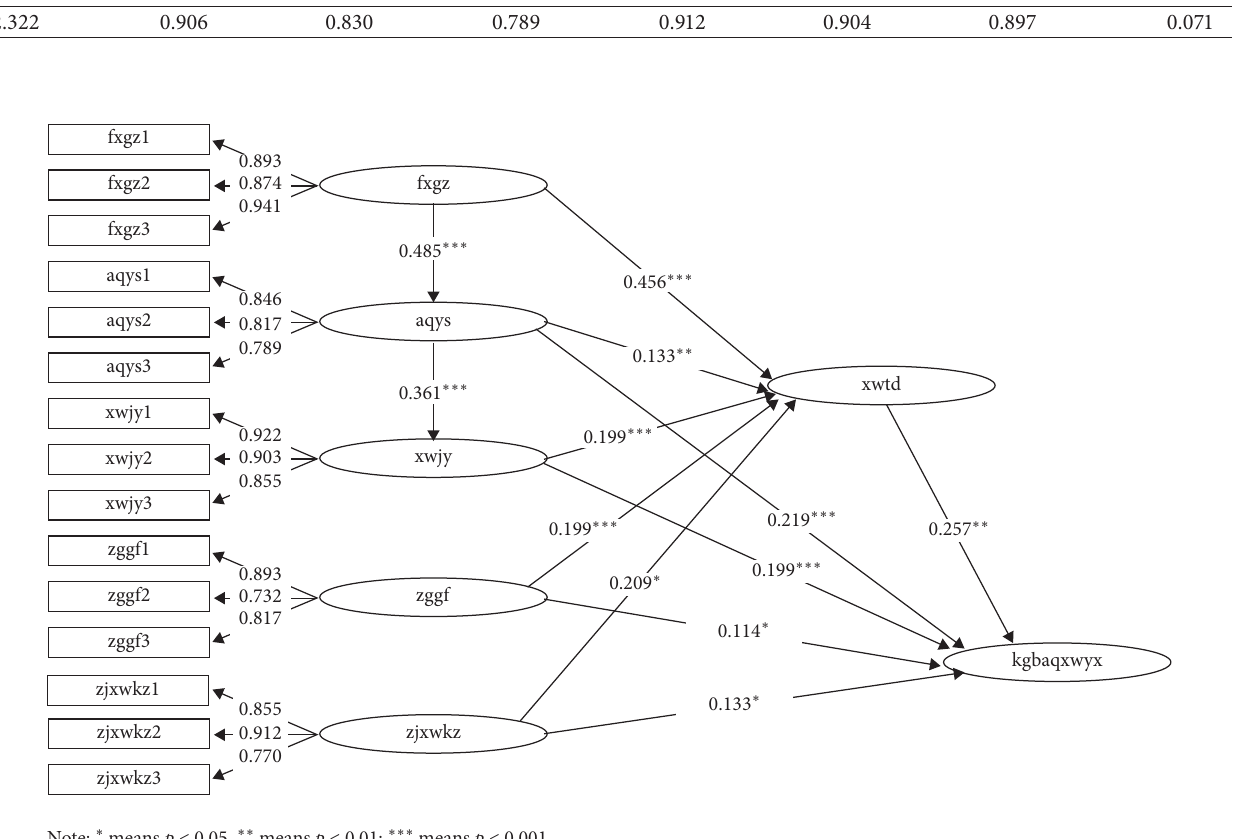
Figure 6: Relational model of influence factors for miners’ unsafe behavior